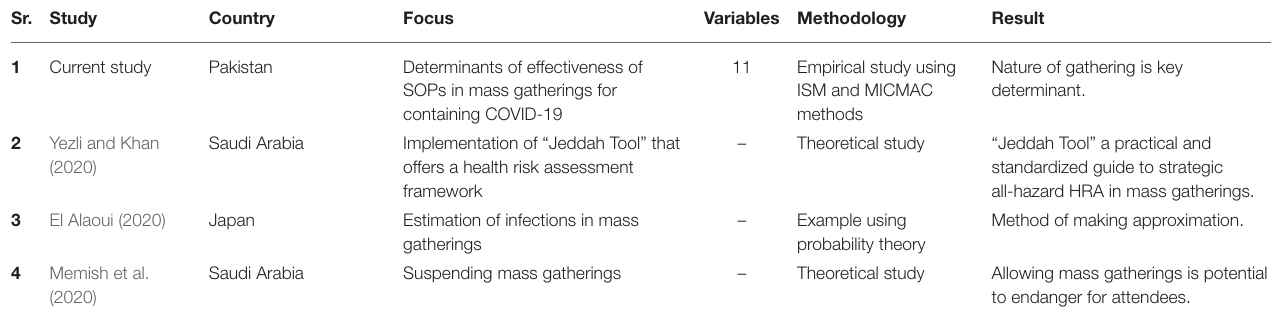
TABLE 12 | Comparison with studies from literature. Sr.